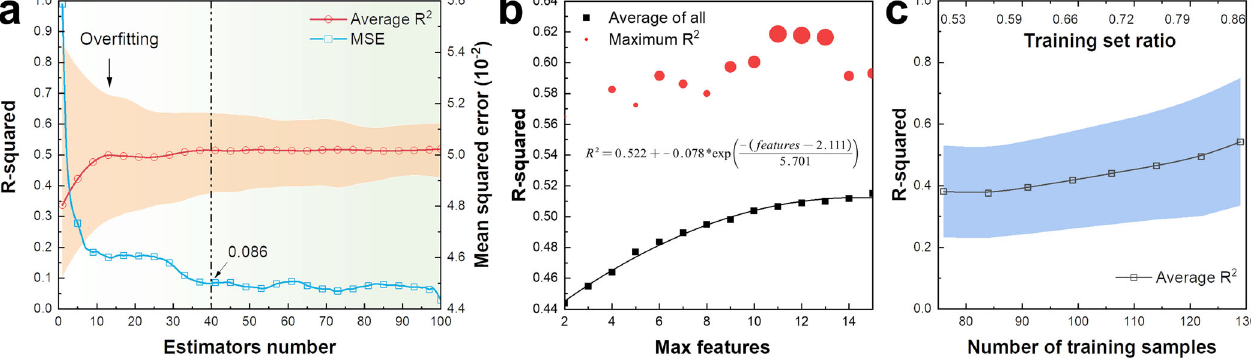
Fig. 2 Analysis of long-term Al alloys fi eld exposure corrosion data by RF model. a The effect of the estimator number on R 2 and MSE. The R 2 improvement with b features and c training set ratio variation. The red symbol size clearly represents the precision of the